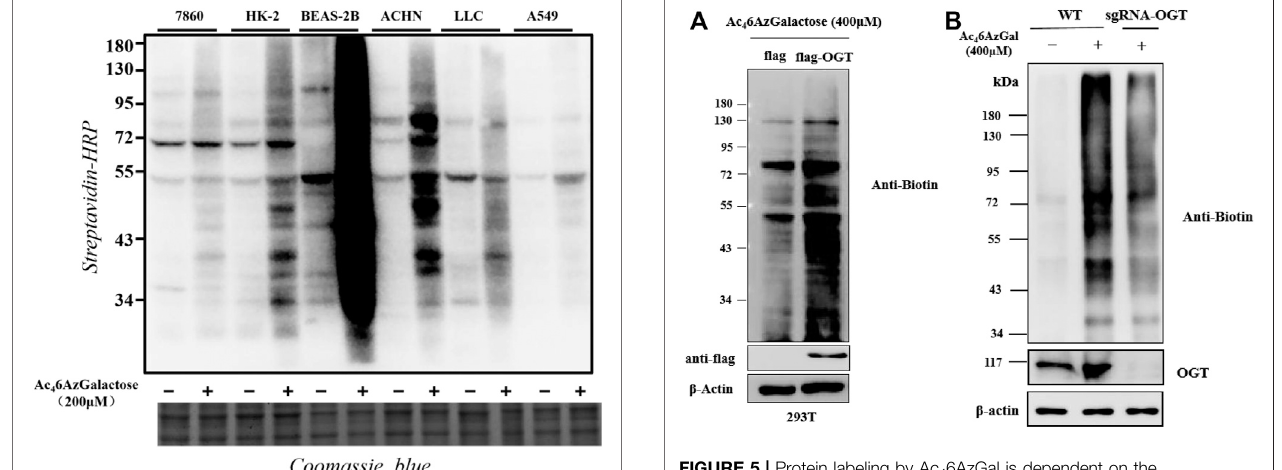
FIGURE 5 | Protein labeling by Ac 4 6AzGal is dependent on the expression of OGT. (A) Over-expressed OGT could enhance the 4 6AzGal